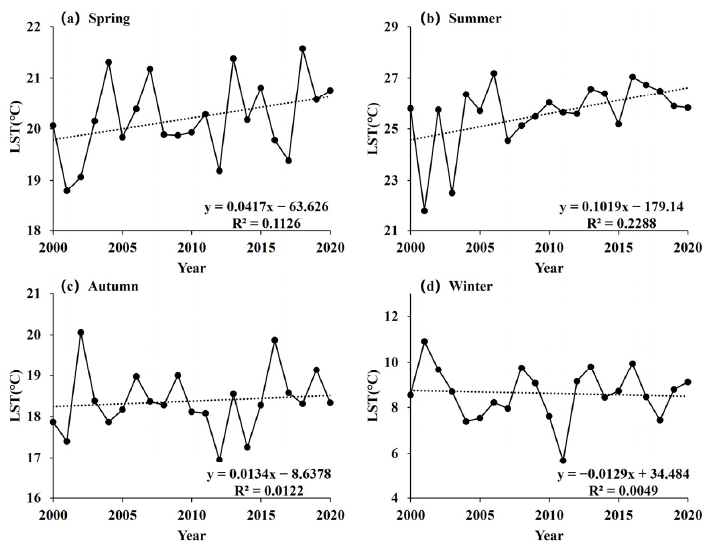
Figure 6. Interannual change trends in mean daytime and nighttime LST in spring ( a ); summer ( b ); autumn ( c ); and winter ( d ) in the Qinling-Daba Mountains from 2000 to 2020.